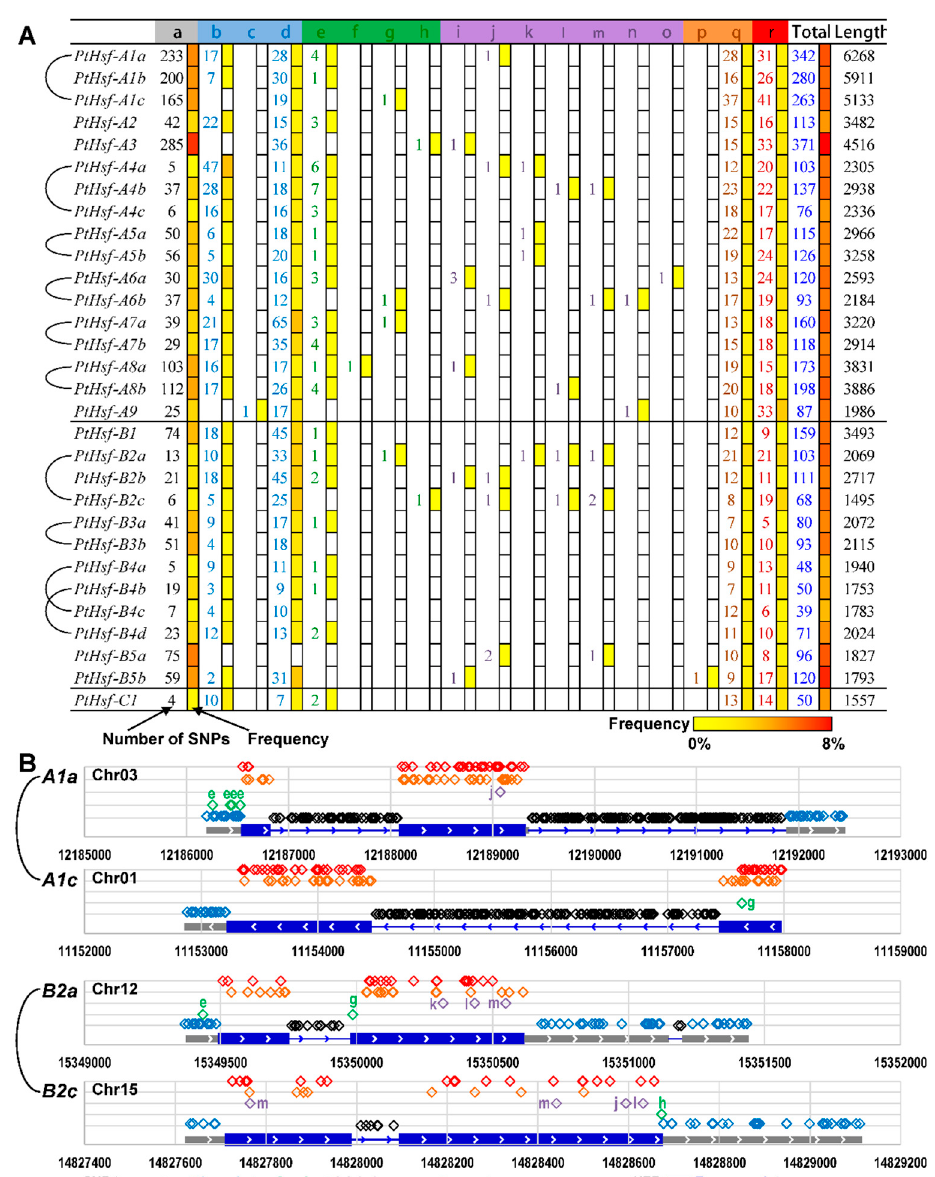
Figure 5. The identified single nucleotide polymorphisms (SNPs) in PtHsf genes from 549 P. trichocarpa individuals based on whole genome re-sequencing. ( A ) The SNPs were classified based on their locations: (a) intron, (b) UTR 5 prime, (c) UTR 3 deleted, (d) UTR 3 prime, (e) start gained, (f) start lost, (g) stop gained, (h) stop lost, (i) frame shift, (j) codon insertion, (k) codon deletion, (l) codon change plus codon deletion, (m) codon change plus codon insertion, (n) splice site donor, (o) splice site acceptor, (p) synonymous stop, (q) synonymous coding, (r) non-synonymous coding. ( B ) Examples of the SNP frequency and location of paralogous pairs PtHsf-A1a / A1c and PtHsf-B2a / B2c . Details of SNPs were listed in Table S3.